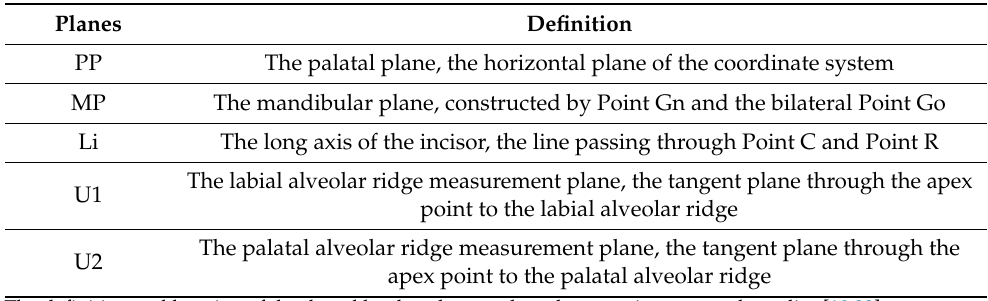
Table 2. Planes for evaluating the angular changes in incisors and alveolar ridge.